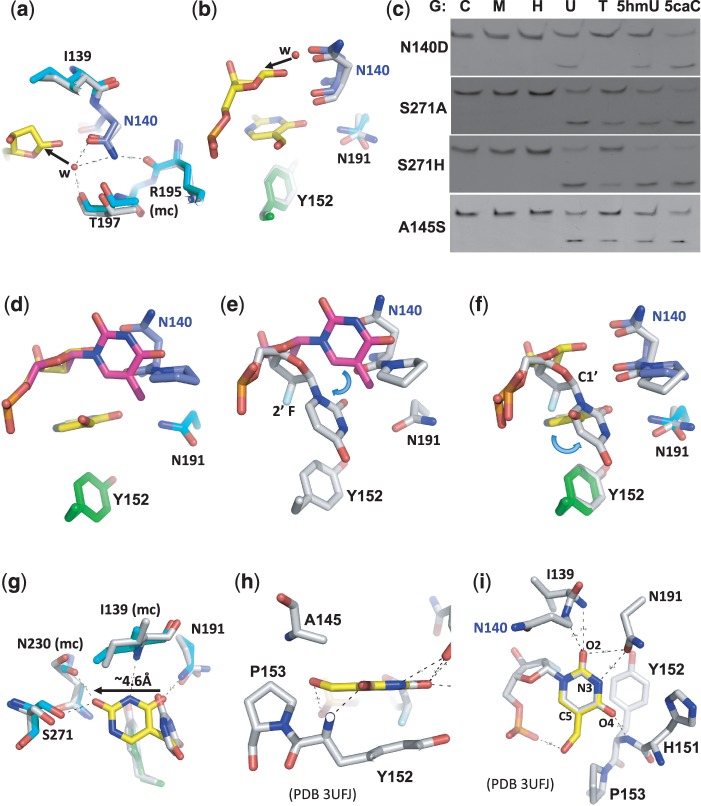
Comparison of post- and pre-reactive complex structures. (a, b) Superimposition of the post-reactive complex (in color) and the pre-reactive complex [in gray; PDB 3UFJ (20)] shows a putative nucleophilic water molecule, held in position by the side chain carbonyl oxygen atom of Asn140 in the pre-reactive complex, attacks the C1′ from the opposite position of the leaving base, generating the C1′-hydrolyzed abasic sugar as shown in the post-reactive complex (in yellow). (c) The activities of TDG mutants N140D, S271A, S271H and A145S. (d, e) Superimposition of a normal intrahelical thymine (colored in magenta) onto the post-reactive complex (panel d) or the pre-reactive complex (panel e) suggests a bent relative to the sugar ring and a rotation around the glycosidic bond. (f, g) Superimposition of the post-reactive complex (in color) and the pre-reactive complex (in gray) suggests the base undergoes another rotation after cleavage (panel f) and moves towards Ser271 (panel g). (h, i) Superimposition of a 5hmU base (in yellow) onto the flipped uracil in the pre-reactive complex (PDB 3UFJ).